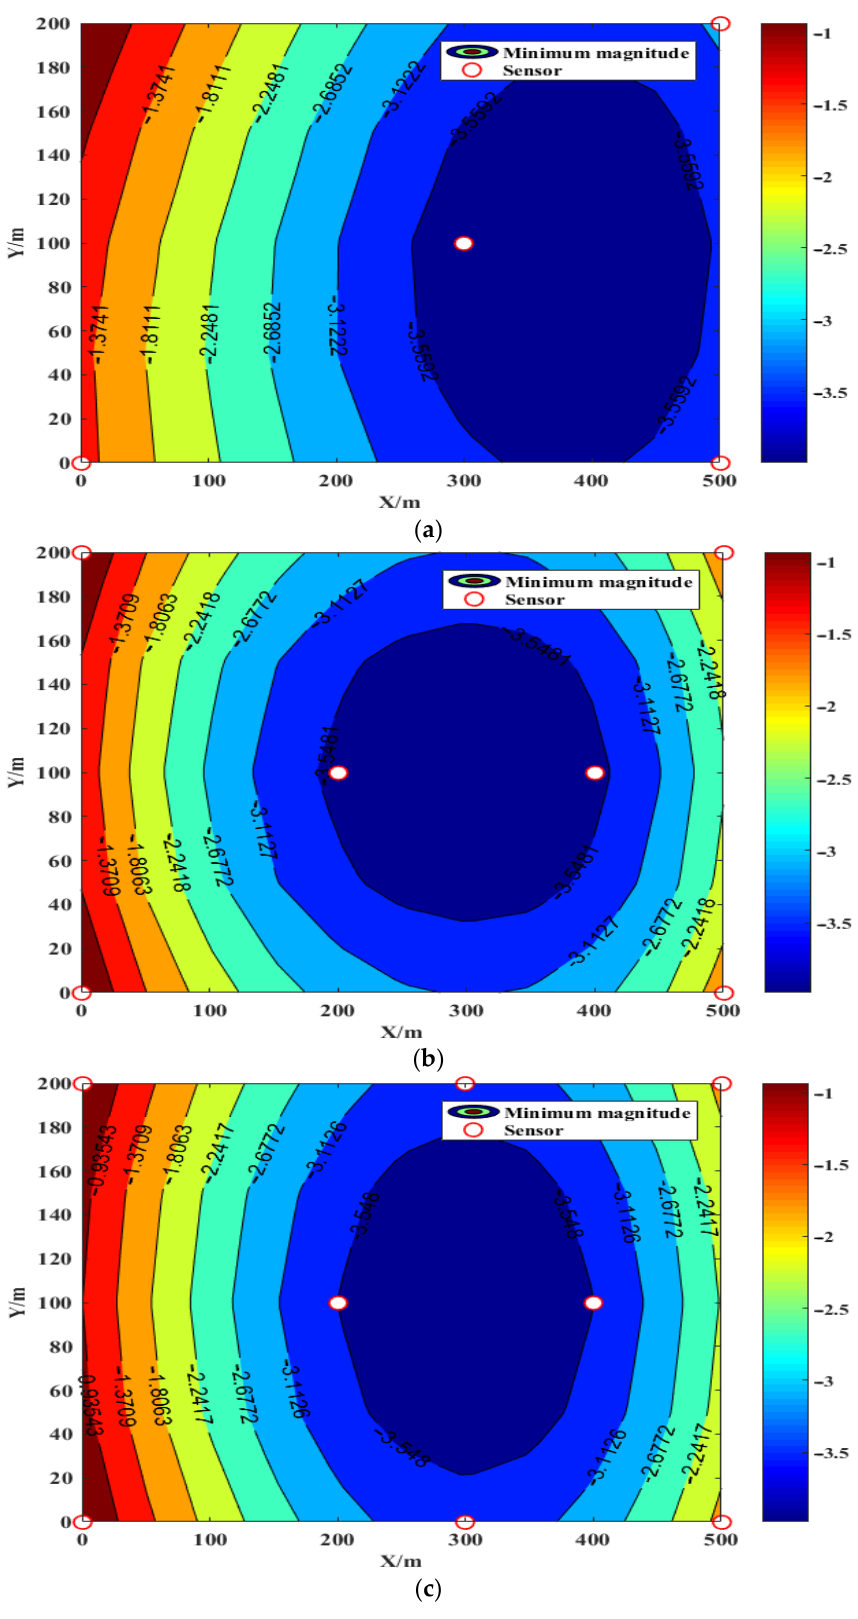
Figure 7. Sensitivity evaluation of different network layout schemes. ( a ) Sensitivity of Scheme I. ( b ) Sensitivity of Scheme II. ( c ) Sensitivity Result of Scheme III.